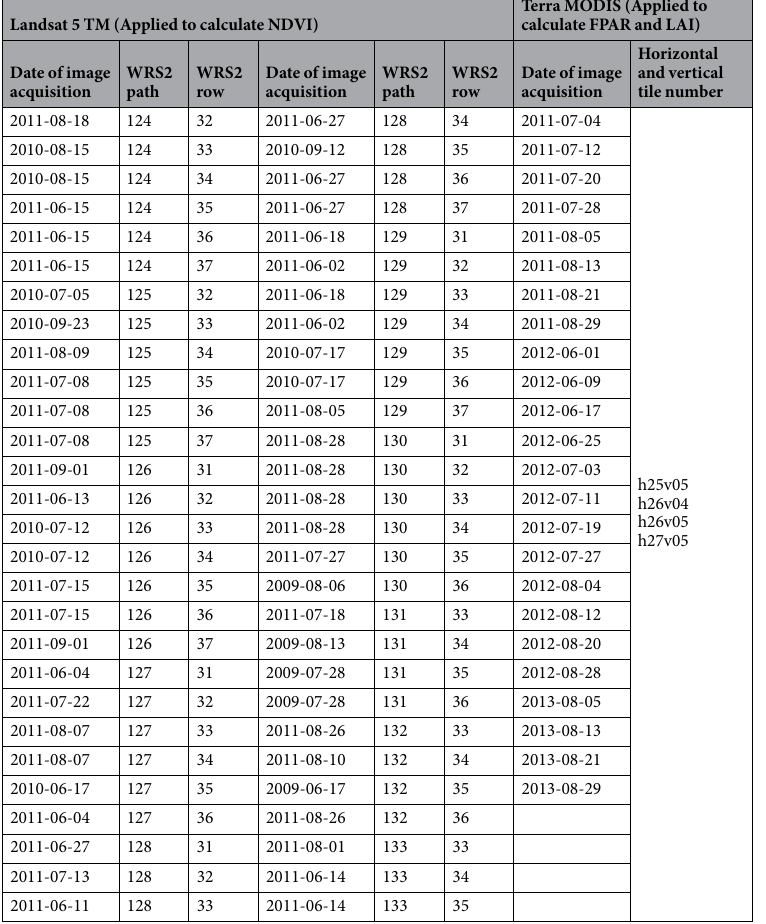
Table 1. Acquisition dates and locations of TM and MODIS